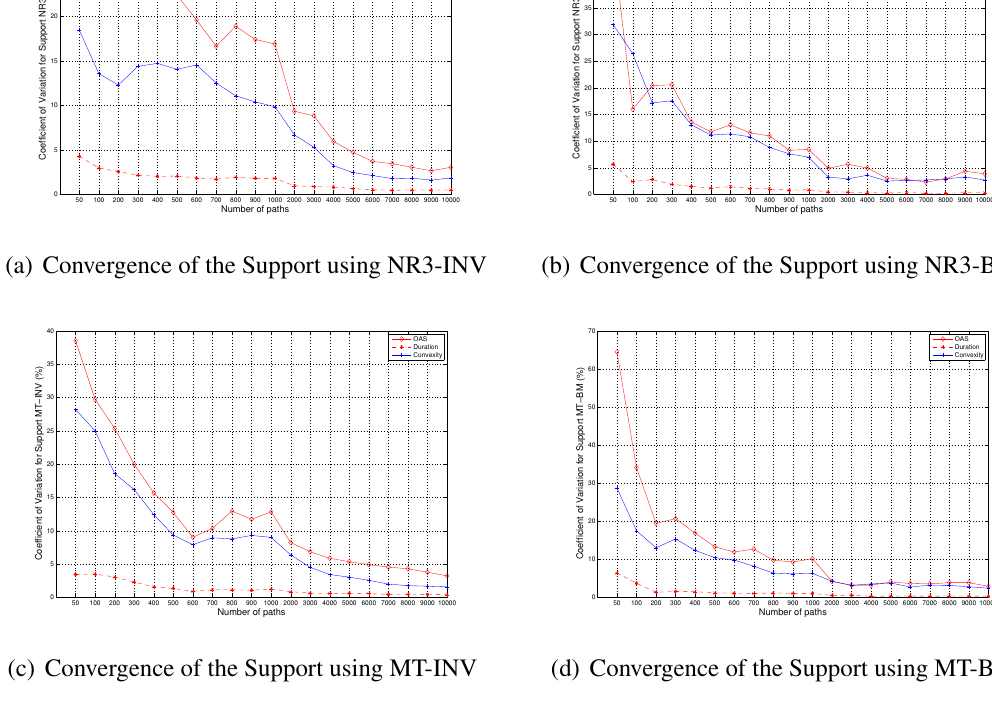
Figure 6. The Convergence of OAS, DUR and CNVX of the Support using different random number generator combinations, NR3-INV, NR3-BM, MT-INV and MT-BM. The vertical axis is for the coefficient of variation (%). The horizontal axis is the number of